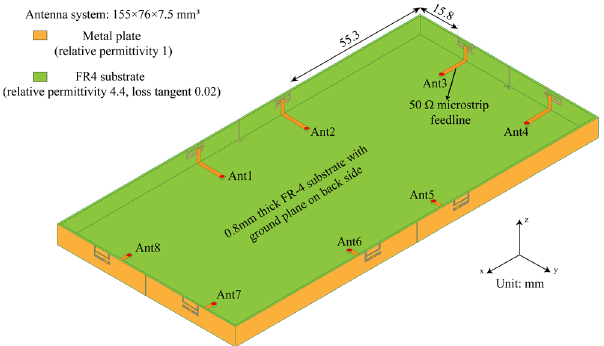
Figure 1. Overall geometry and dimensions of the proposed MIMO antenna array.